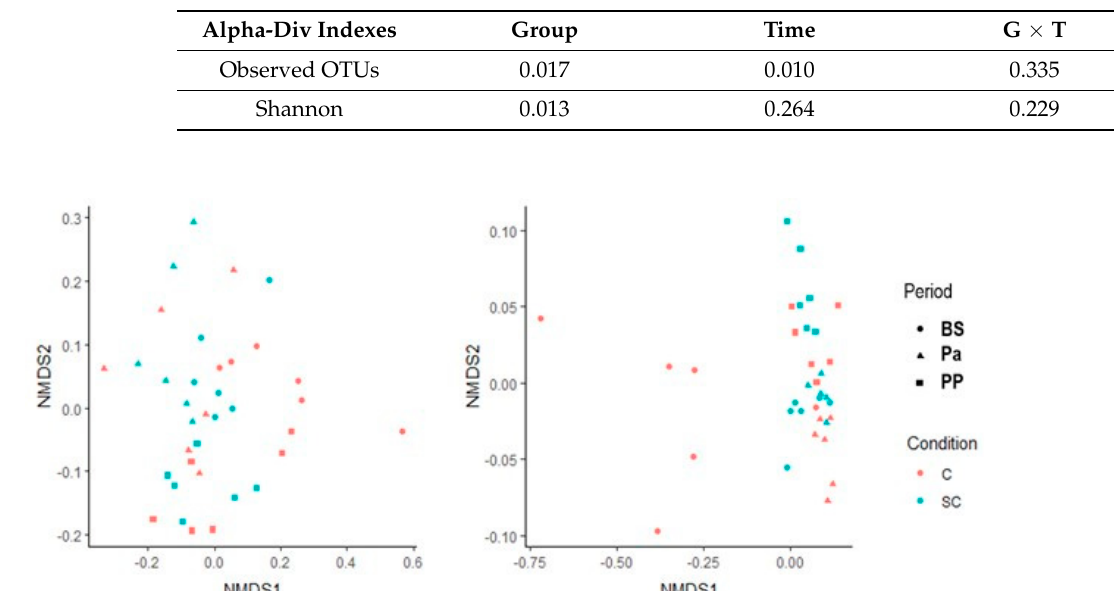
Figure 2. Non-metric multidimensional scaling representation for the bacterial and archaeal communities in the ruminal ( left ) and the fecal ( right ) samples. Circle = BS; triangle = Pa, square = PP.